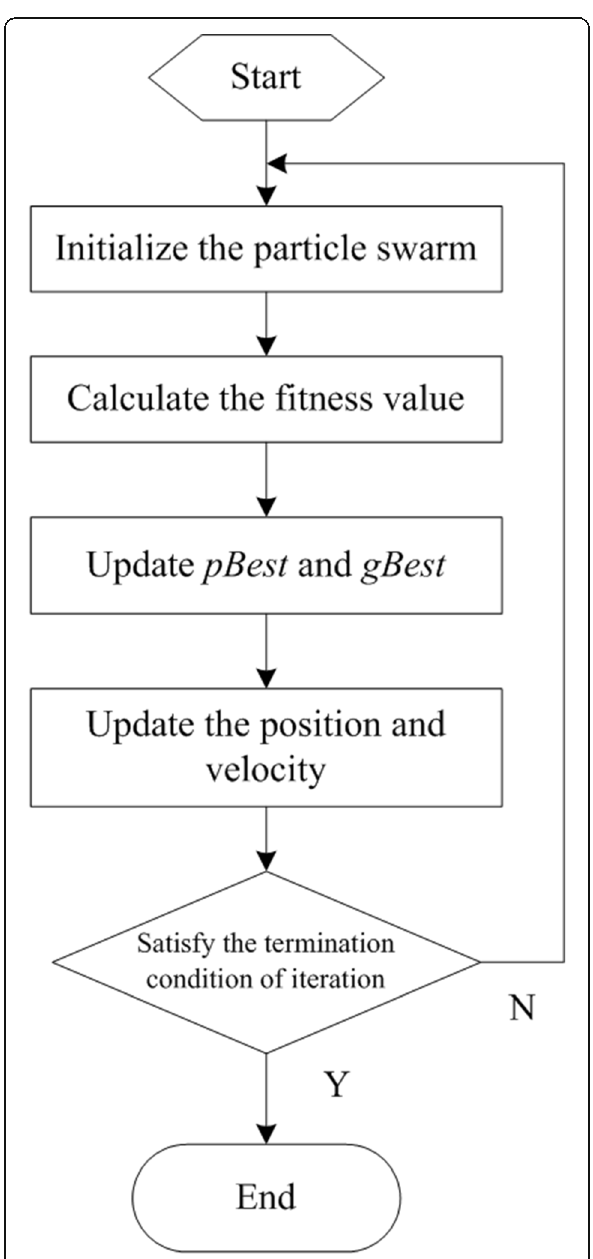
Fig. 3 Flow chart of particle swarm